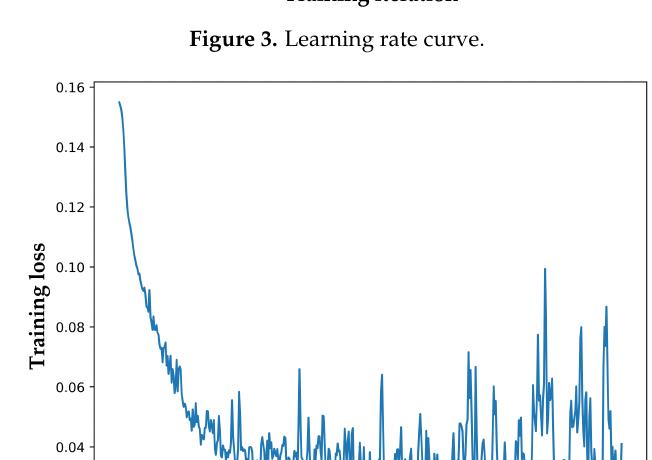
Figure 3. Learning rate curve.